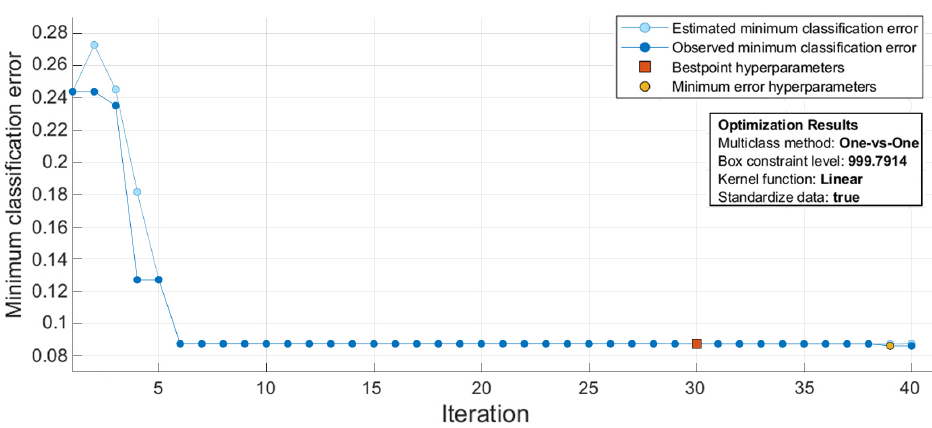
Figure 8. Exemplary results of the Bayesian optimizer for the SVM classifier, reporting the error for each single